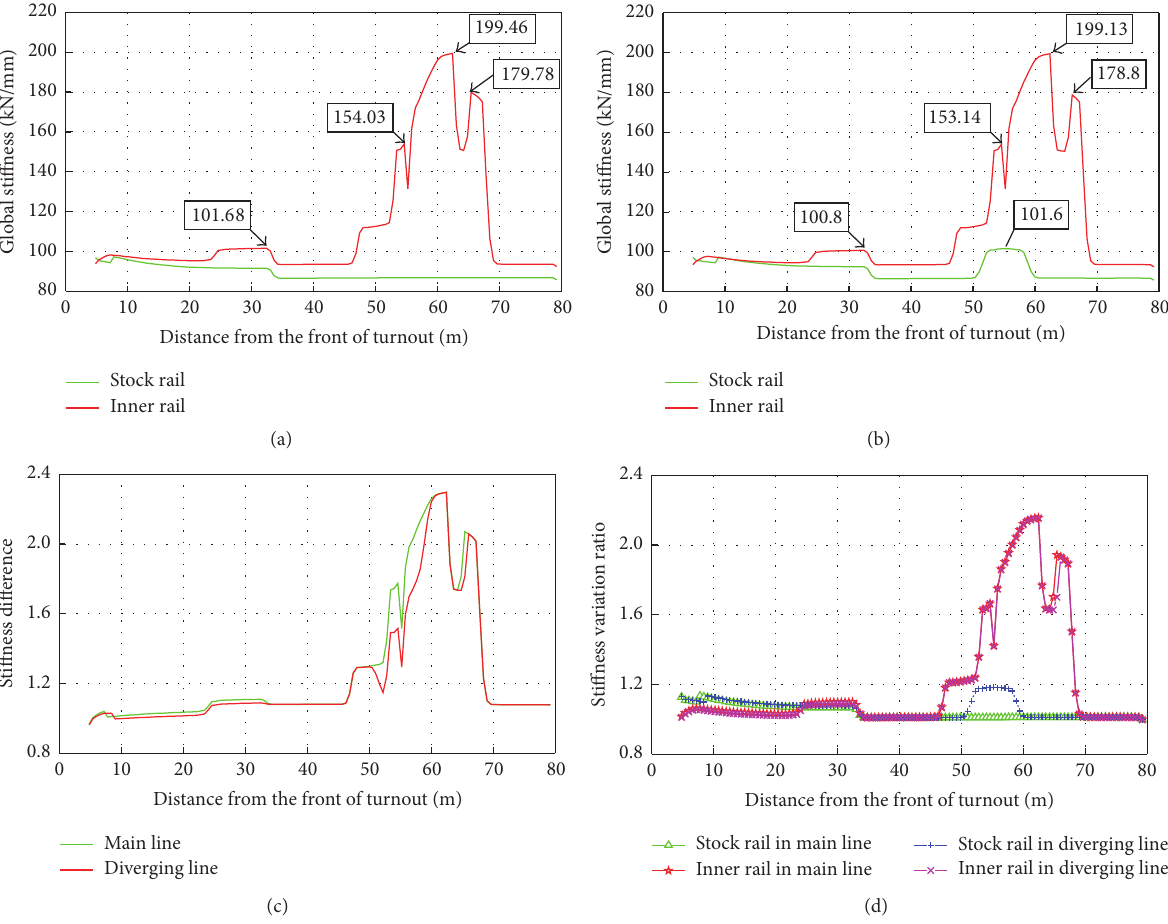
Figure 4: Distribution of stiffness in a high-speed turnout ((a) the main line; (b) the diverging line; (c) the stiffness difference of turnout rails; (d) the stiffness variation